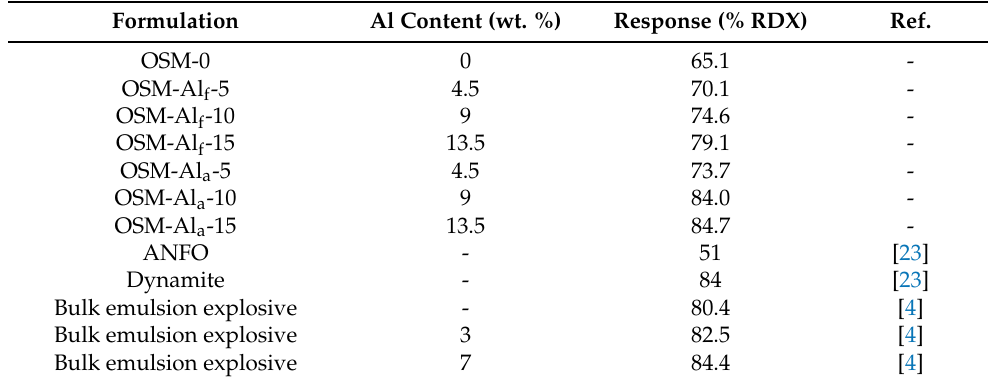
Table 2. Relative ability to perform mechanical work, determined via the ballistic mortar method, with RDX as the reference explosive.